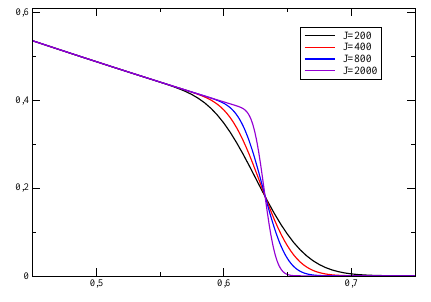
Figure 5. Results of numerical experiments computed with the regularized implicit Euler